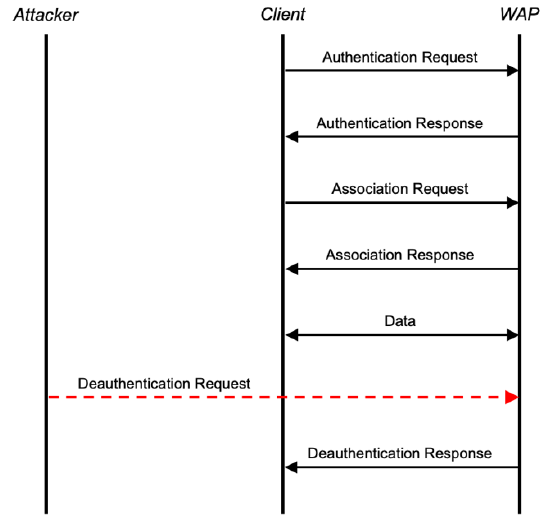
Figure 1. Deauthentication attack process.